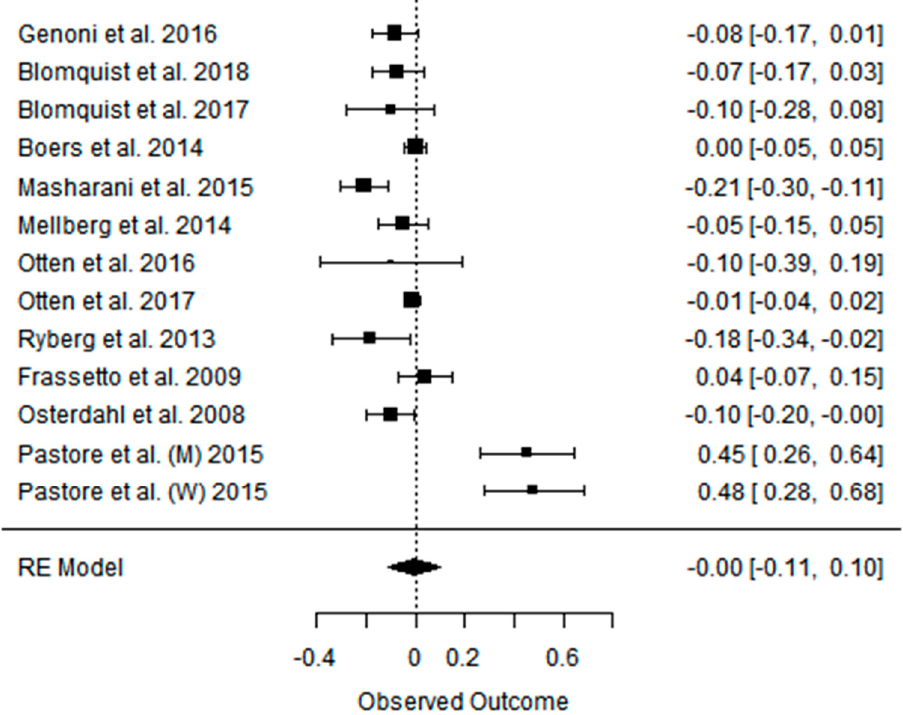
Figure A20. Forest plot of the effect of a PDs on HDL-C in the short term (weighted mean difference).